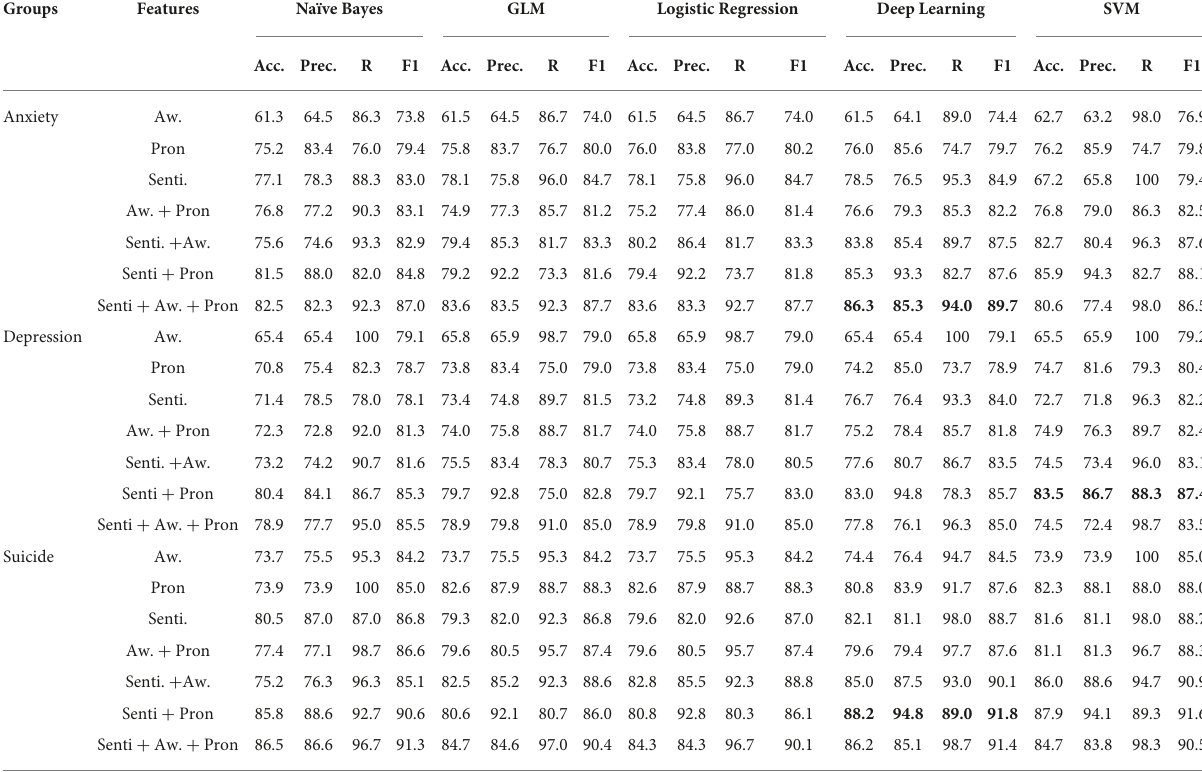
TABLE 4 Performance of machine-learning